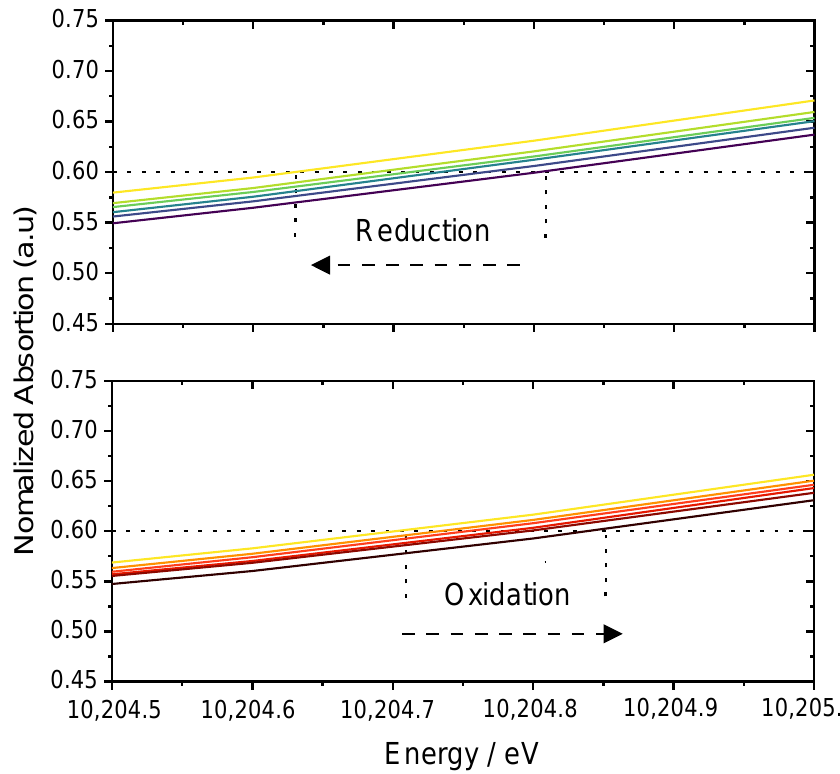
Figure 5. Operando XAS for Li-HTB. W L 3 -edge normalized absorption evidencing the changes in energy while cycling the electrodes, upon reduction and oxidation from 0.0 to − 0.6 V and back to 0.0 V vs. Ag/AgCl at 2 mV.s − 1 .